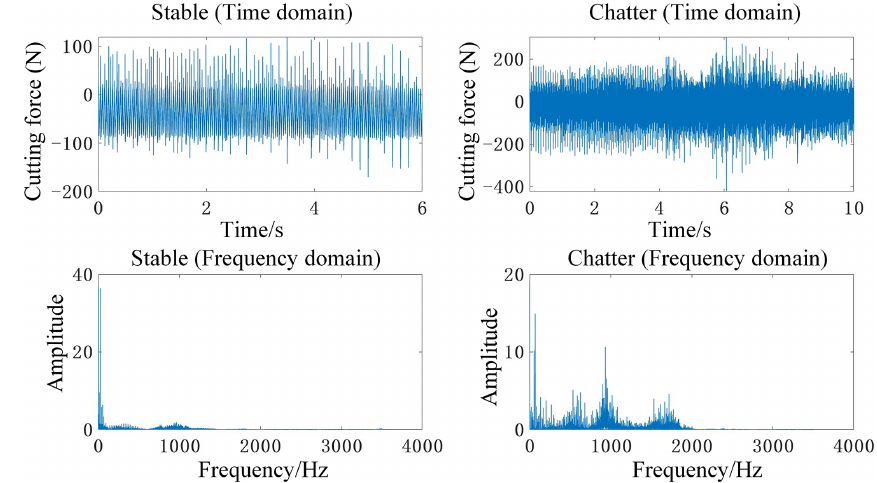
Figure 13. Time and frequency domain analysis of two processing states.